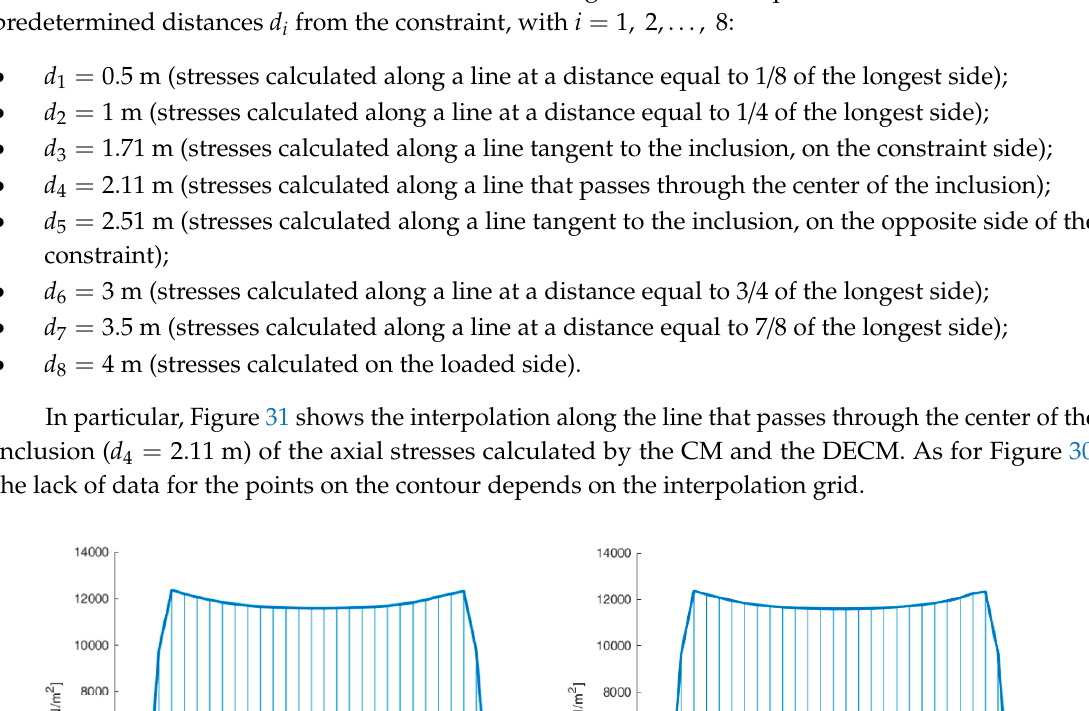
(stresses calculated along a line tangent to the inclusion, on the constraint side);